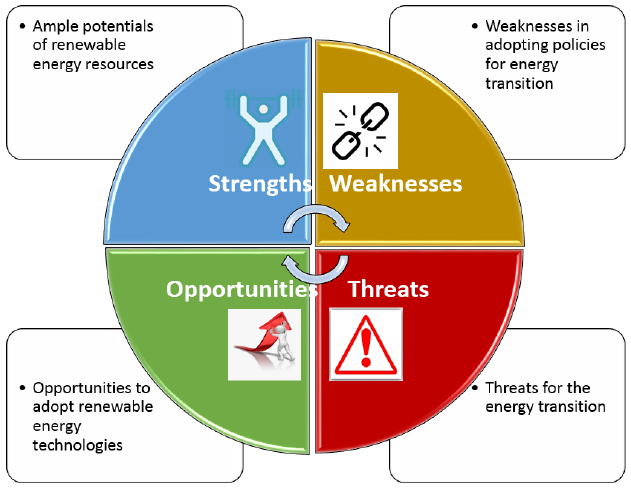
Figure 1. Cognitive map of the strengths, weaknesses, opportunities, and threats (SWOT) analysis.